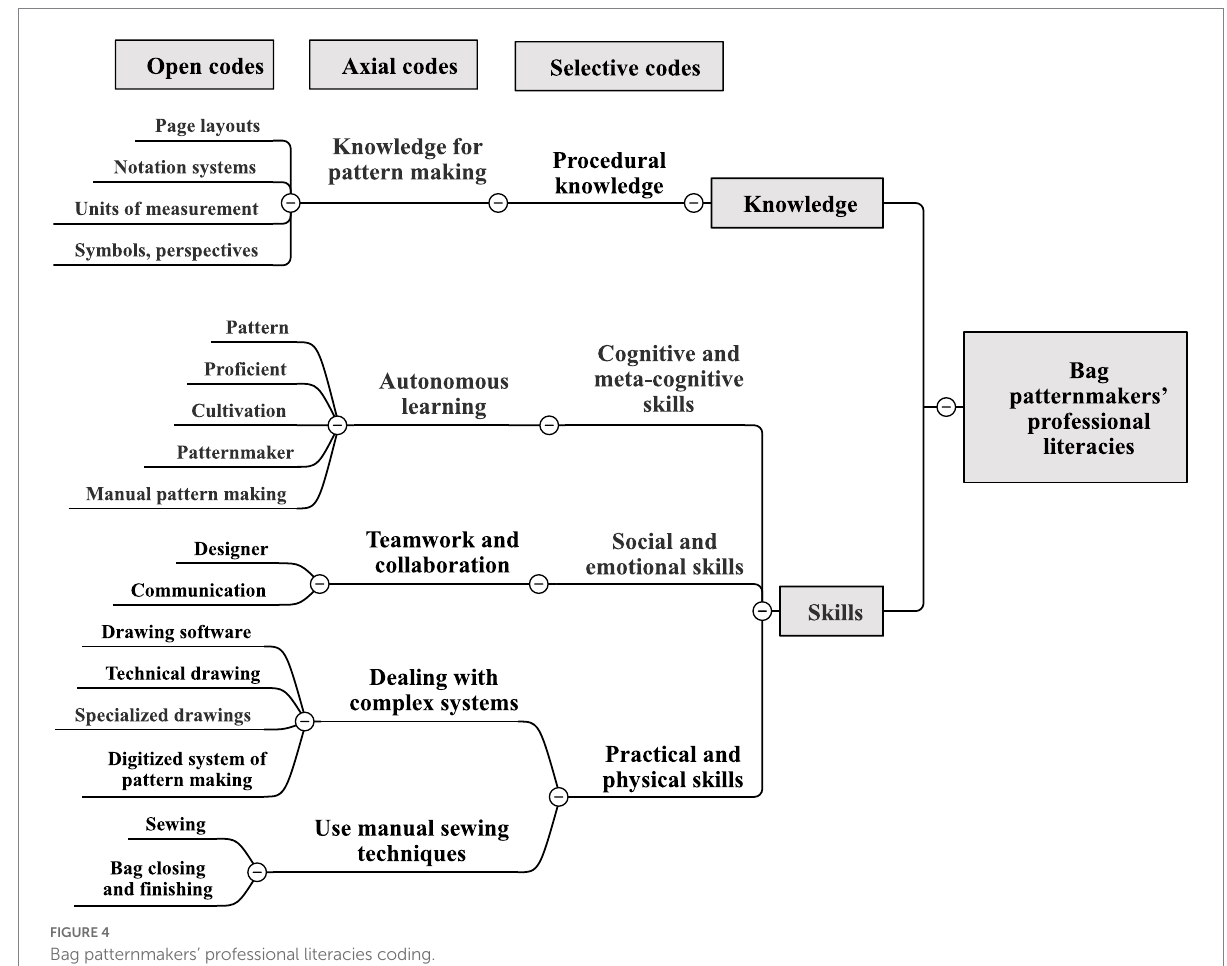
FIGURE 4 Bag patternmakers’ professional literacies